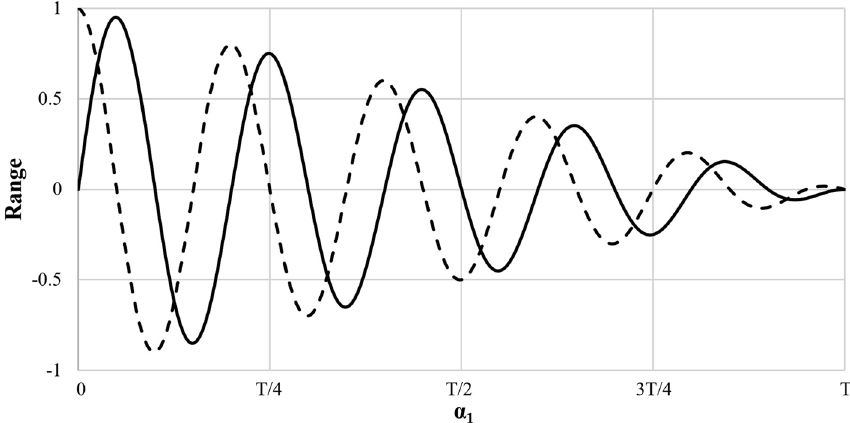
Figure 4. Decreasing pattern for range of sine and